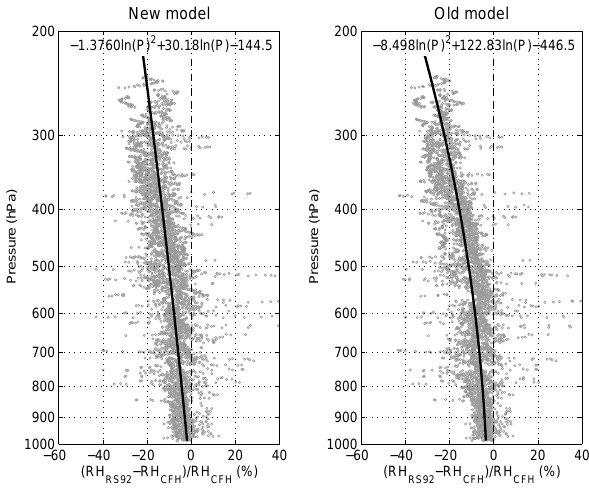
Fig. 1. Relative difference between RS92 and CFH (cryogenic frost point hygrometer) humidity profiles during daytime flights in So- dankyl¨a from June to August 2007. The new model of the RS92 sonde (left) is using aluminized coating of the sensor attachment, which reduces the radiation dry bias compared to the earlier ver- sion of the RS92 (right). Both RS92 sonde models and also the CFH sonde were flown in the same balloon payload during the EPS/Metop Sodankyl¨a campaign. The CFH sonde is here used as a reference for both RS92 sonde